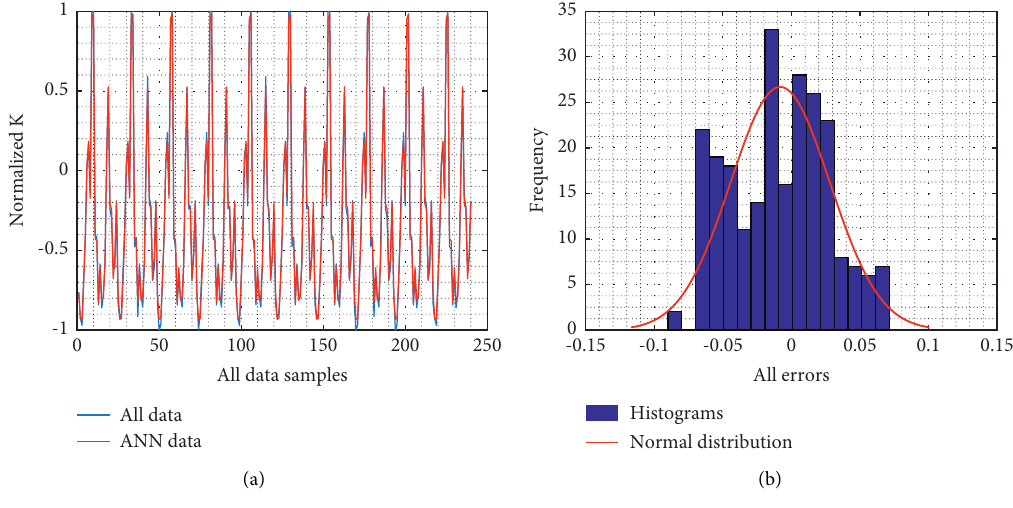
Figure 7: All-data performance.